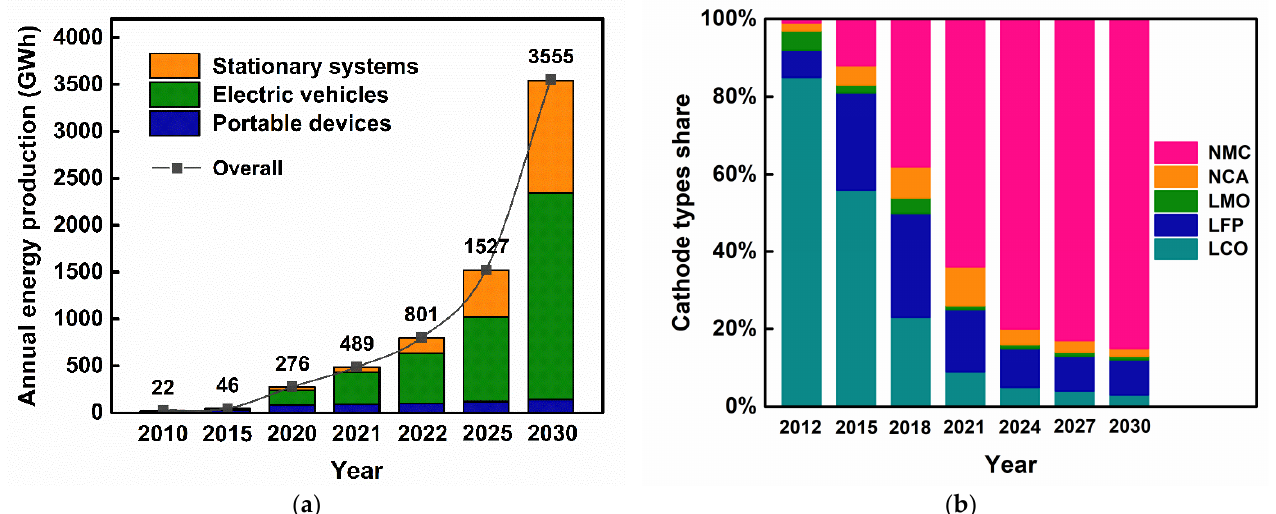
Figure 3. History and forecast of ( a ) cumulative energy supplied by LIBs operated within portable devices, electric vehicles, and stationary energy storage systems (data from [58–61]) and ( b ) annual market share between cathode types (in installed GWh) (data from [62]).